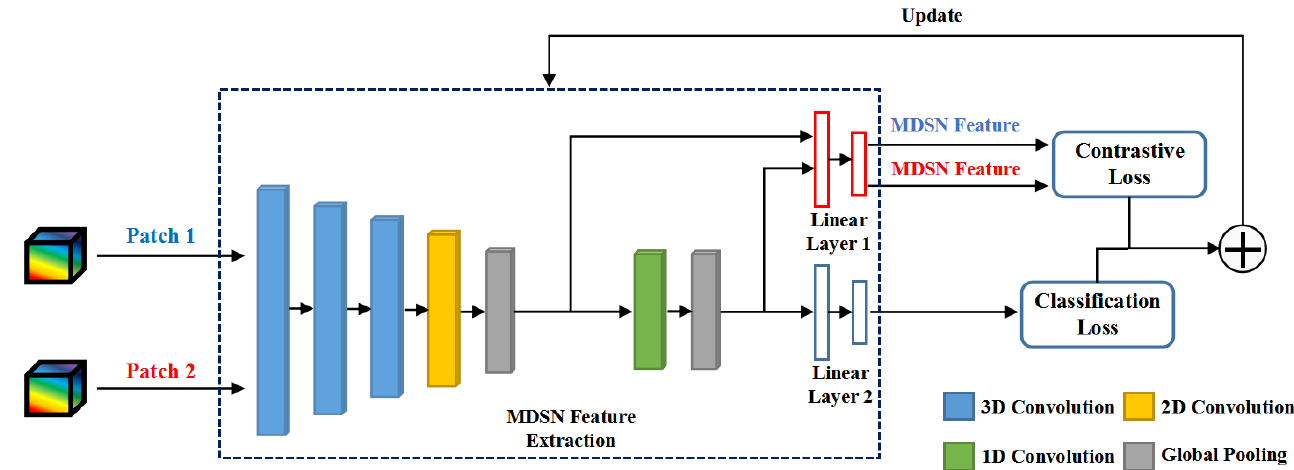
Figure 3. The structure of MDSN. Each convolutional block contains a convolutional layer, a batch normalization layer and a ReLU nonlinearity corresponding to its convolutional dimension. When performing the contrastive learning, two different patches are adopted at the same time. In the classification phase, only one patch is used.